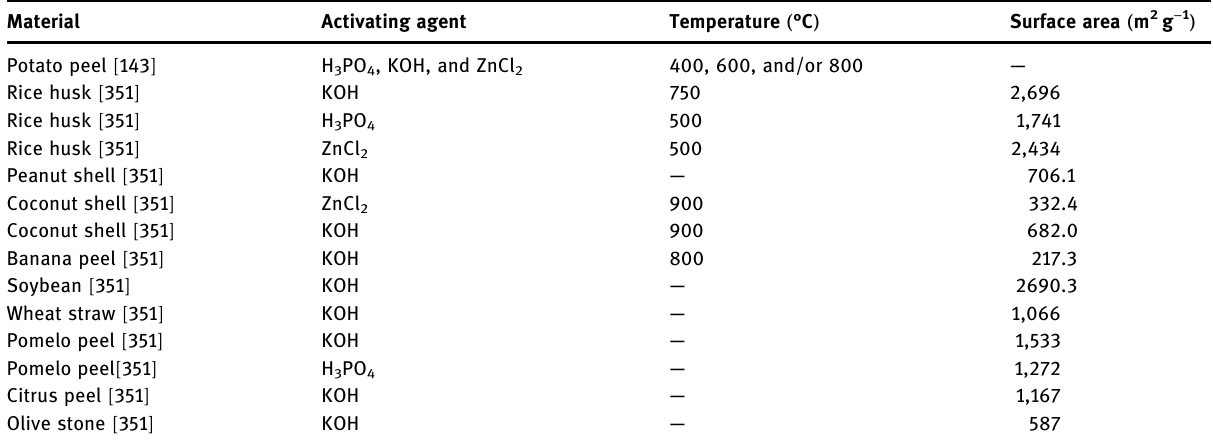
Table 4: Di ff erent chemical methods for AC production from biomass with corresponding properties